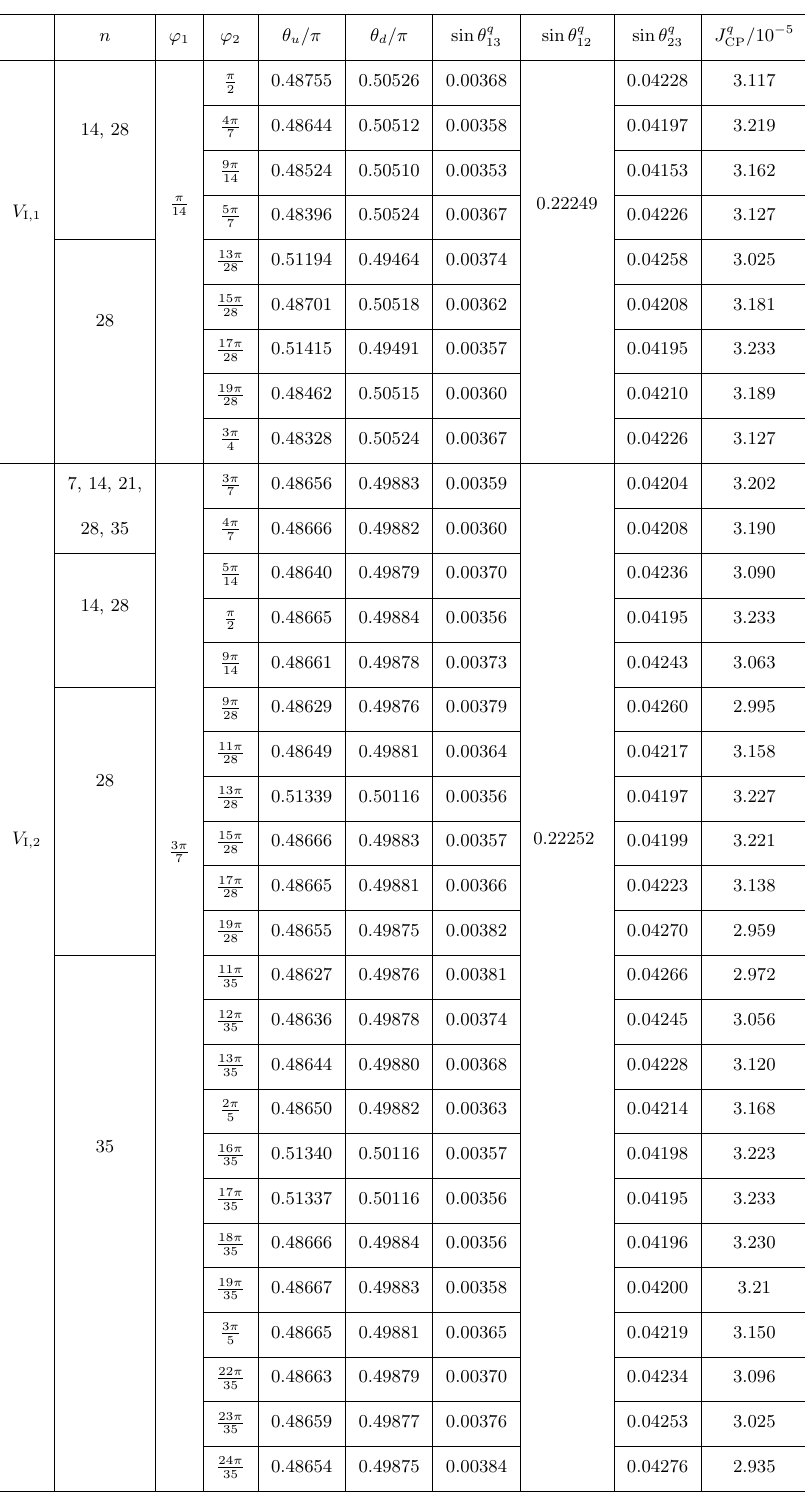
Table 9 . Results for the quark mixing parameters obtained from the mixing patterns V I ; 1 and V I ; 2 with n (cid:20) 40. We display the values of sin (cid:18) q